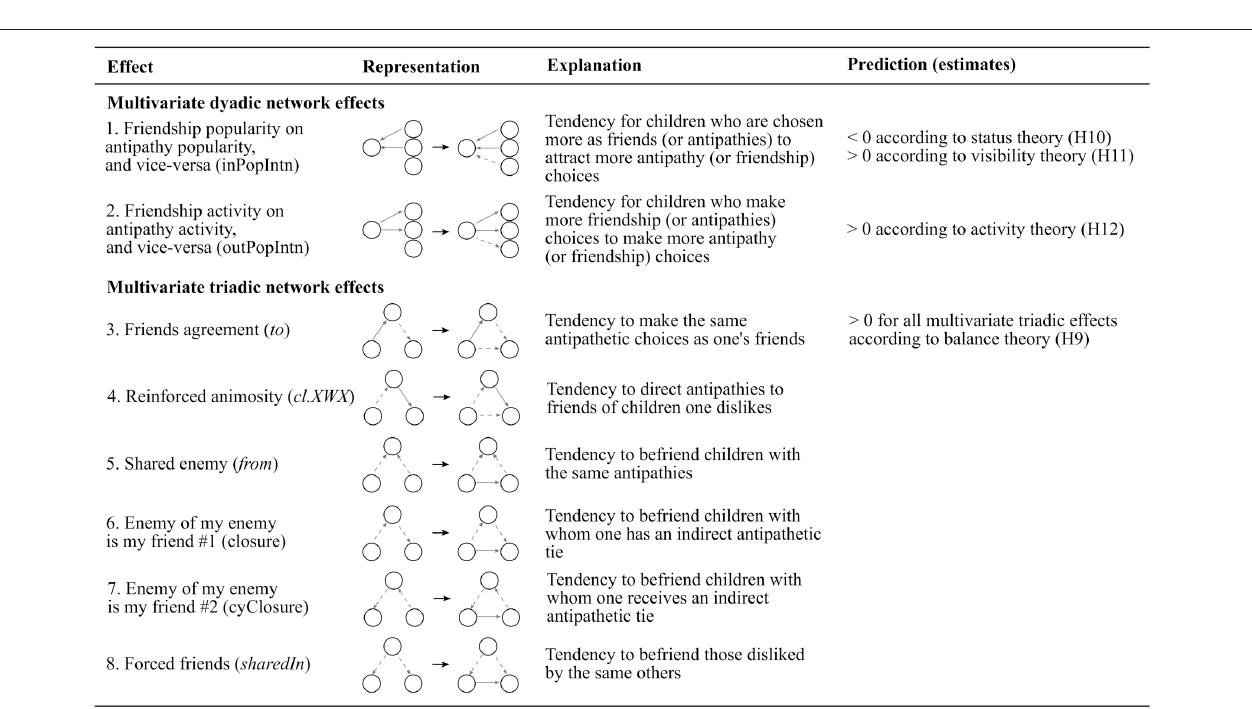
FIGURE 2 | Summary of SIENA univariate effects. If the predicted estimate equals 0, the corresponding effect is expected to play no role in the network dynamics; if positive, the formation (or maintenance) of ties that create the corresponding representation are expected to occur; and the converse if the predicted estimate is negative. For detailed explanations concerning these predictions please see Sections Positive Ties and Negative Ties. Out-degree effect (average tendency to form ties) can be interpreted similarly to the intercept of regression models; out-degree activity effect was included a posteriori to improve model fit, and ego and alter sex covariate effects are included to control for possible sex differences in the number of ties.